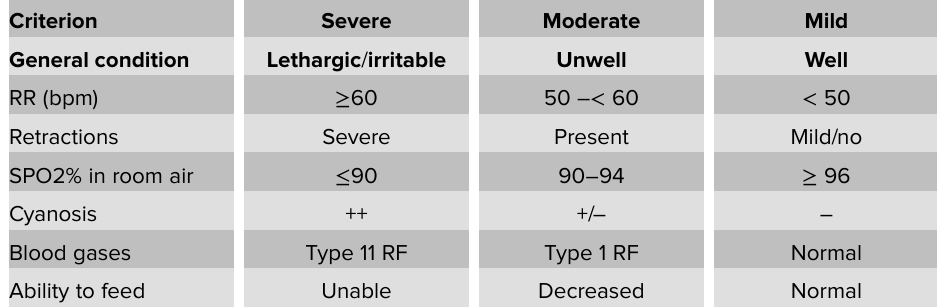
TABLE 1: Definition of the severity